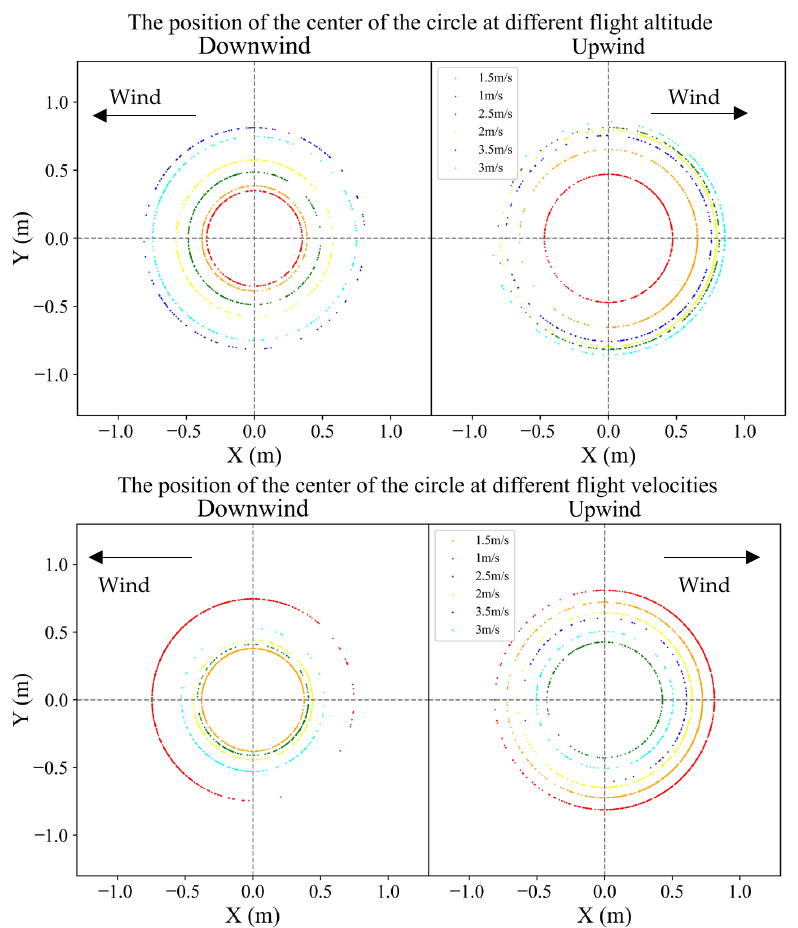
Figure 12. Orientation of the circumscribed circle relative to the inscribed circle. Note: Data points of different velocities or altitudes are distributed on circles with different radii. The radius of the circle represents the average distance between the two circle centers at the velocity or altitude, and the direction of the points on the circle relative to the origin of the coordinates represents the relative distance between the centers of the circumscribed circles. The direction of the center of the circumscribed circle relative to the center of the inscribed circle represents the protruding direction of the wind vortex.